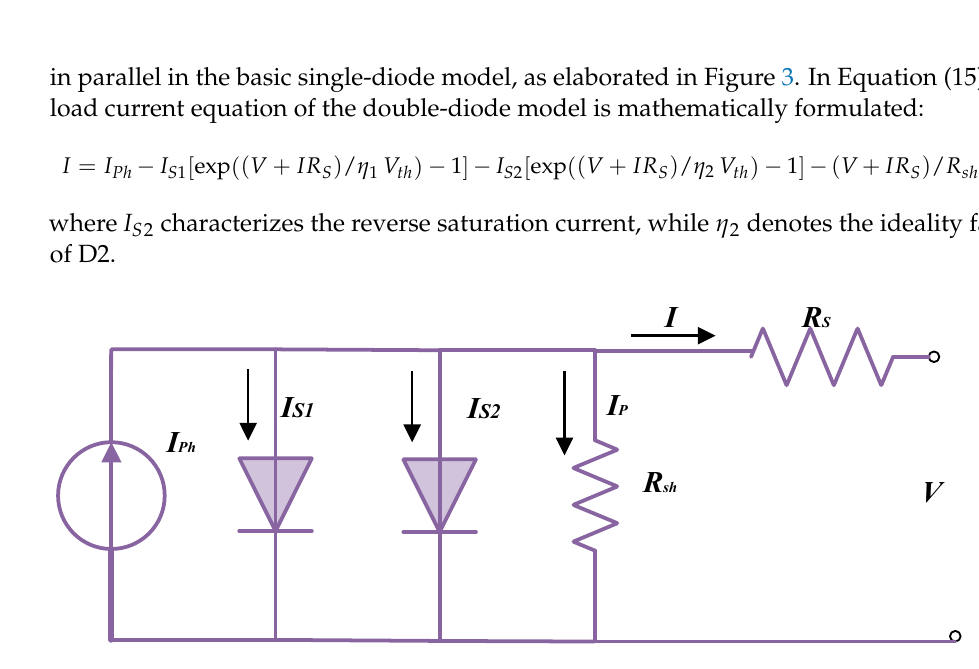
Figure 3. The electrical circuit of the double-diode model.